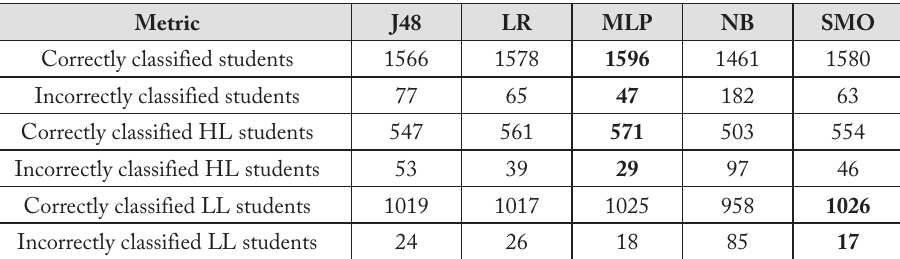
Table 2: Comparison of models’ performance on training dataset, based on correctly and incorrectly classified student